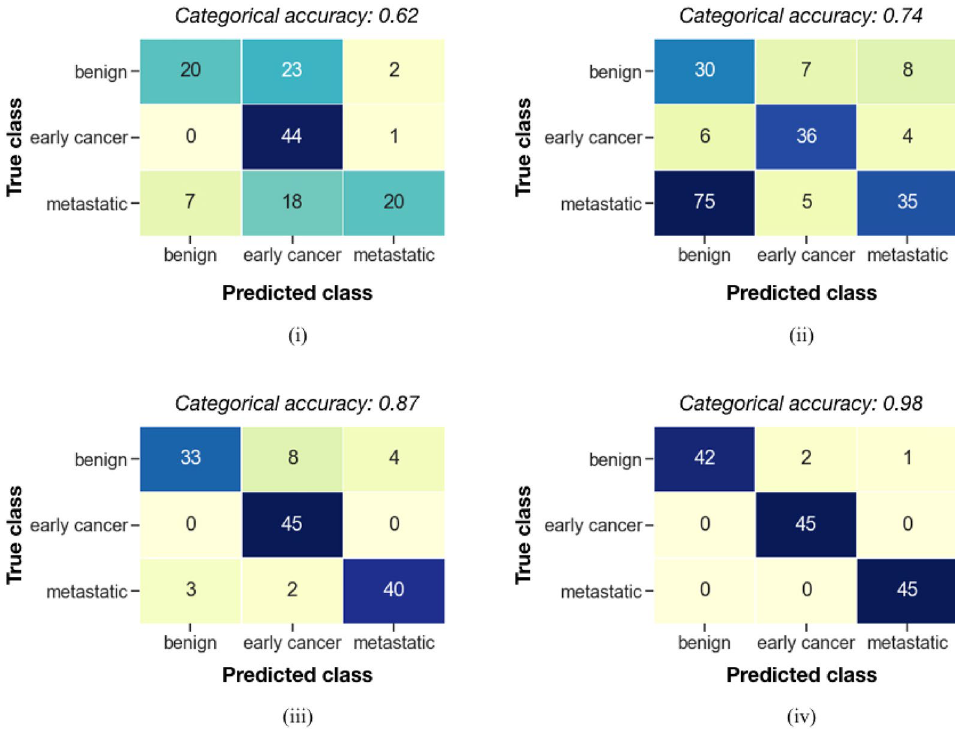
Figure 5. Out-of-sample confusion matrices for (i) KNN, (ii) decision tree, (iii) SVM and (iv) MLP model types. For each trialled model type, a single confusion matrix was derived from tenfold cross validation by aggregating the results for the 10 disjoint test folds. Since each individual sample features only once in a test fold, the confusion matrix features each sample exactly once, and the values per matrix sum to the total number of available samples in the full dataset. The corresponding categorical accuracy scores are reported, summarising the confusion matrix content for each model